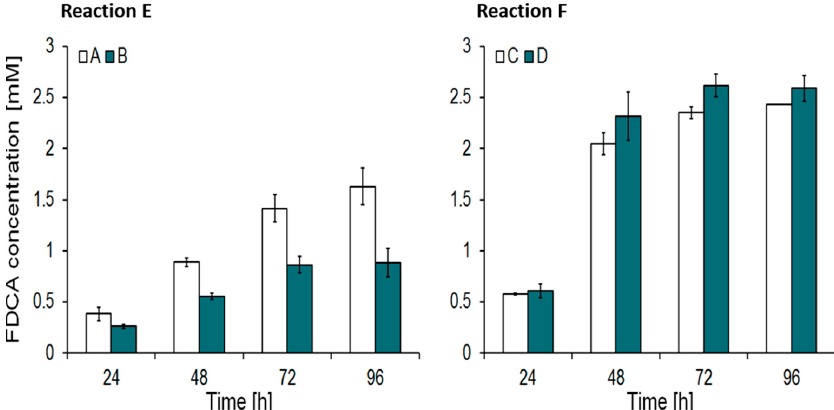
Figure 1. Enzymatic hydrolysis of poly(ethylene 2,5-furanoate) (PEF) powders (see Table 1 for powders characterization details) with different molecular weights (104 kDa (E)/29 kDA (F)), particle sizes (d < 180 μ m (A, C)/180 < d < 425 μ m (B, D)) and crystallinities (46% (E)/amorphous (F)). No release products were detected in control reactions. All experiments were performed in triplicates.